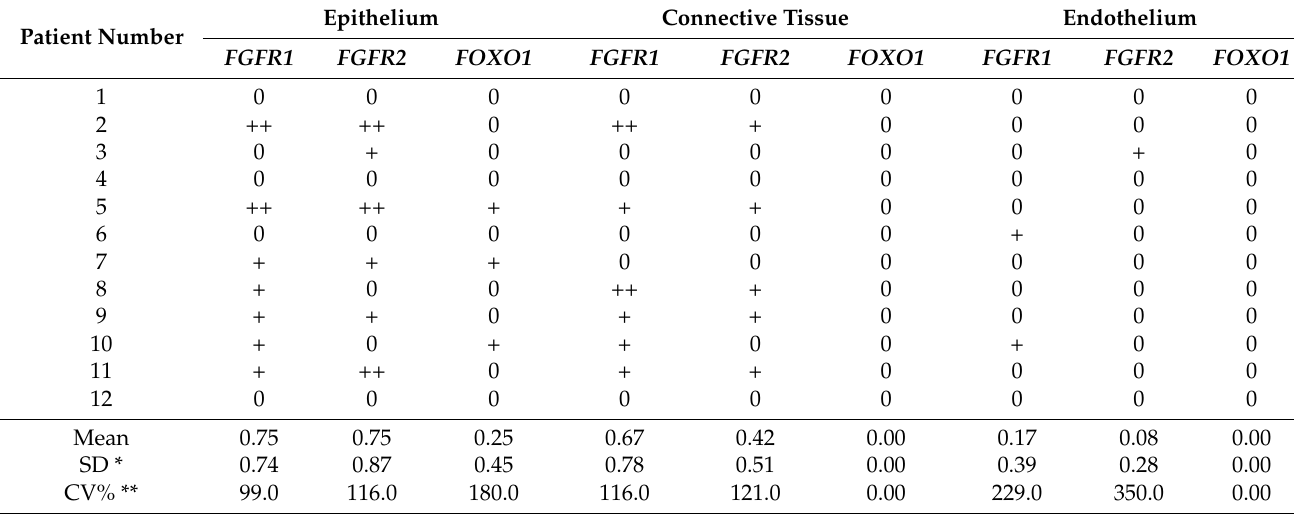
Table 4. Results by patient (semi-quantitative grading scale) for the CISH analysis.